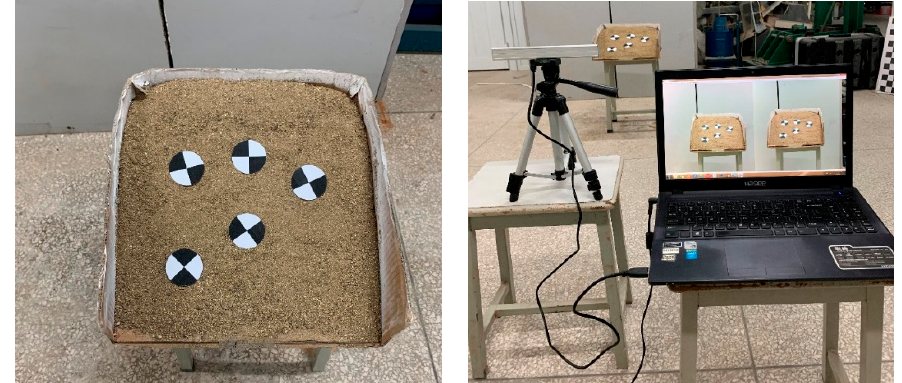
Figure 5. Examples of image samples. Sensors 2020 , 20 , x FOR PEER REVIEW